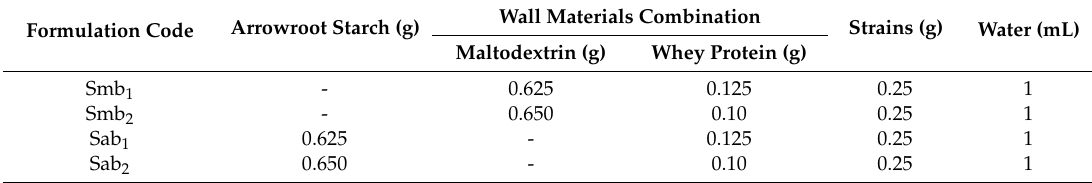
Table 1. Schema of encapsulated bacteria formulation